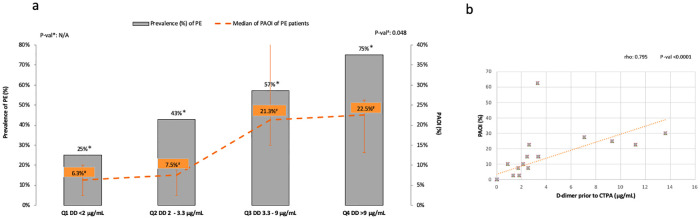
Relation between PAOI and D-dimer.a. PE prevalence and PAOI median of PE patients divided by D-dimer quartiles of the entire population. b. D-Dimer and PAOI correlation in PE patients. Abbreviations: a. Prev., prevalence; PAOI, pulmonary arterial obstruction index; PE, pulmonary embolism; Q1, first quartile; Q2, second quartile; Q3, third quartile; Q4, fourth quartile; DD, D-dimer; NA, not applicable. b. PAOI, pulmonary arterial obstruction index; CTPA, computed tomography pulmonary arteriography.